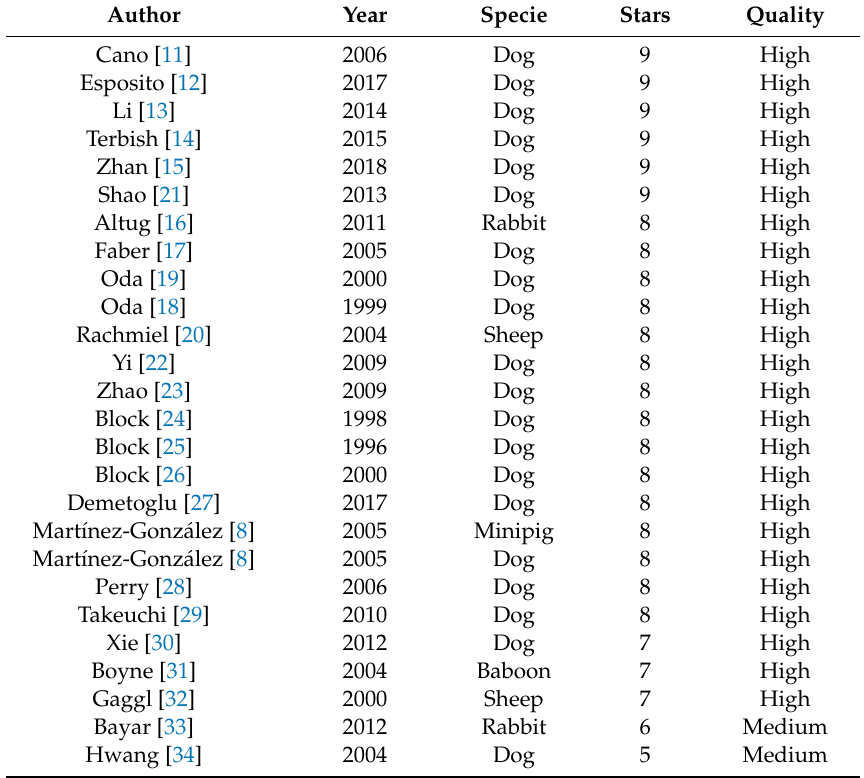
Table 1. Score by studies using NOS